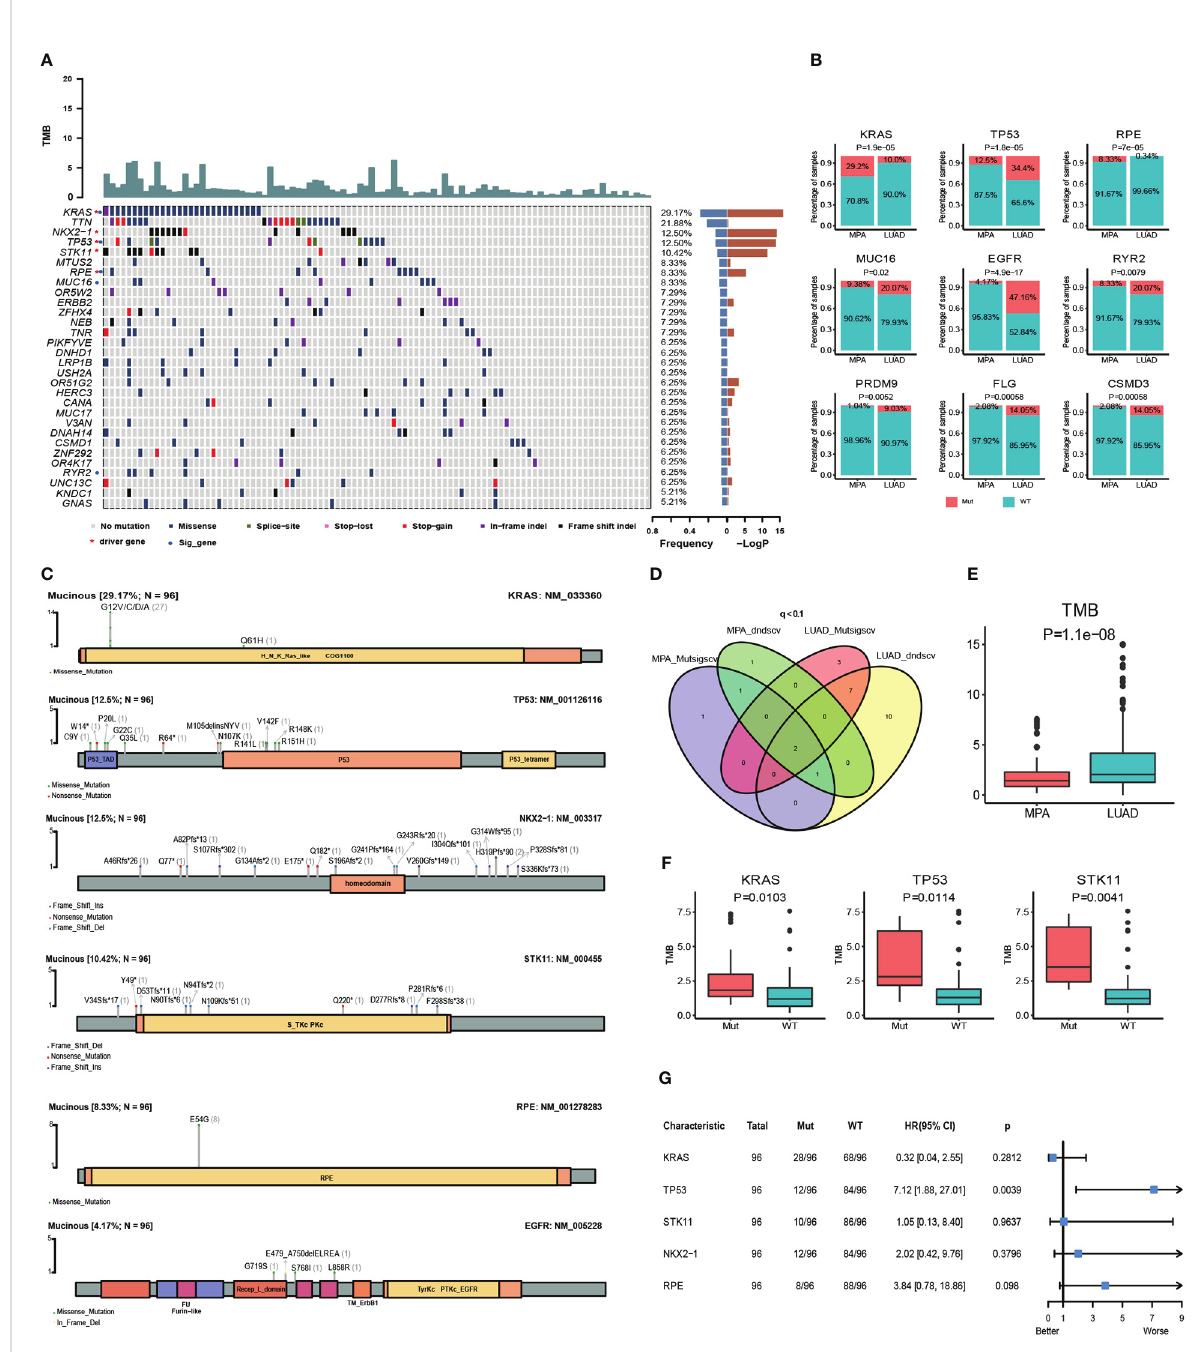
FIGURE 1 Somatic mutations and clinical association in MPA. (A) , Recurrently mutated genes and mutant frequencies of top 30 in lung mucinous adenocarcinoma. The blue in the histogram on the right shows the mutation frequency of these 30 genes, and the red is the -log P -value when predicting whether the gene is a driver gene. There are red asterisks (driver genes predicted by the software) and blue circles (genes with a signi fi cant difference in mutation frequency between lung mucinous adenocarcinoma and lung adenocarcinoma) on the right of the gene name on the left. (B) , Compared with lung adenocarcinoma, lung mucinous adenocarcinoma has a signi fi cantly different mutation frequency. In the histogram, red indicates the frequency of mutation, and blue indicates the frequency of no mutation. (C) , Lollipop diagram of fi ve driver genes and EGFR mutations in MPA. The speci fi c mutation type of each gene and the number of mutations of each mutation type are marked on the map. (D) , Venn diagram of the number of MPA and LUAD driver genes predicted by Mutsigscv and dndscv software. (E) , TMB comparison between MPA and LUAD. (F) , Comparison of TMB between mutant and wild-type in fi ve driver genes of MPA. Red is the mutant type, and blue is the wild type. (G) , Survival analysis of fi ve driver genes in